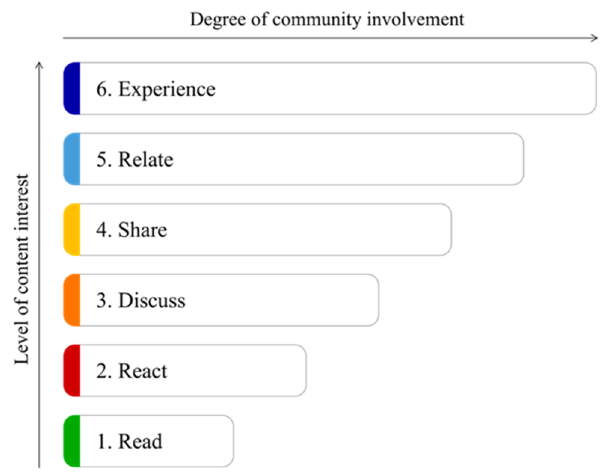
Figure 2. Reader’s journey relating the level of content interest and the degree of community involvement. Retrieved from Gamifying News for the miOne Online Community (Regalado 2021) .